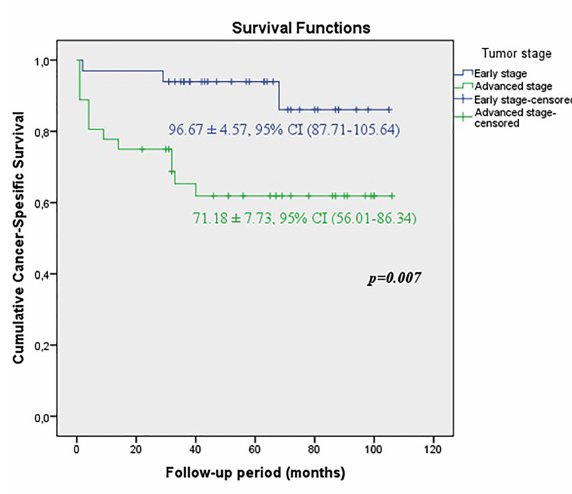
Figure 1B - Kaplan-Meier plots of cancer-specific survival according to the early and advanced stages for all